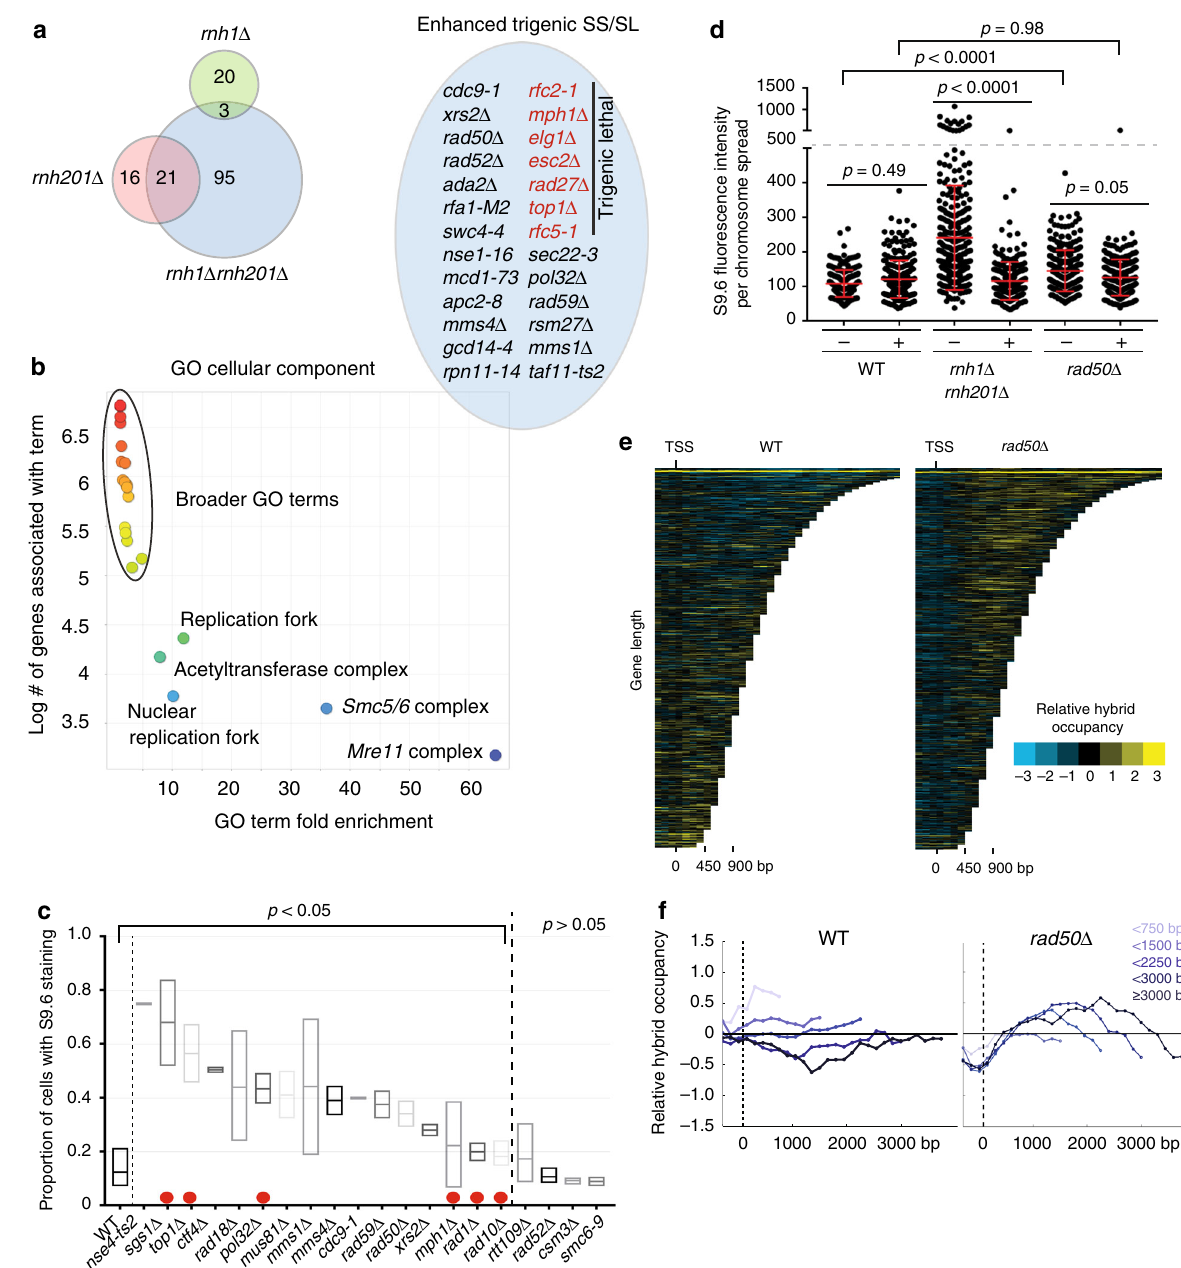
Fig. 1 RNaseH-de fi cient yeast depend on replisome function and fork protection for fi tness. a Negative genetic interaction results of double and triple mutant SGA screens with the indicated query genotype. A Venn diagram of candidate negative genetic interactions is shown (left) and validated hits that are sicker as triple mutants are in the blue circle. b Gene Ontology analysis of negative rnh ΔΔ -interacting partners. Plots show the output of ReviGO, which effectively trims redundant GO terms. c S9.6 staining of chromosome spreads in the indicated strains. Strains between the dotted lines had a signi fi cantly higher proportion of stained nuclei than WT (Fisher exact test. p < 0.05, Holm – Bonferroni corrected). Red dots indicate predicted positive controls (see main text). Box plots show the minimum and maximum values with the line at the mean value. d Validation of DNA:RNA hybrid increases in rad50 Δ cells. The minus and plus signs indicate that cells were grown without or with an RNH1 overexpression plasmid. e and f Mean genome-wide relative DNA:RNA hybrid occupancy in WT, and rad50 Δ as a function of gene length. Pro fi les were generated in duplicate. Quantile normalized and mean data are shown here. e Chromatra plots showing a heat map of DNA:RNA hybrid levels in WT, and rad50 Δ . f A total of 4868 genes were split into the indicated gene length categories (538 genes < 750 bp, 1861 genes < 1500 bp, 1263 genes < 2250 bp, 636 genes < 3000 bp, and 570 genes ≤ 3000 bp) with mean enrichment scores calculated and plotted for each category de fi cient yeast 31 . Therefore, we fi rst con fi rmed by quantitative that deletion of RAD50 led to increased DNA:RNA hybrid growth curve analysis that triple mutants of rnh ΔΔ and either formation by quantifying S9.6 staining in rad50 Δ yeast with or rad50 Δ or xrs2 Δ had a signi fi cant loss of fi tness (Supplementary without RNH1 overexpression (Fig. 1d). This analysis con fi rmed Fig. 1B). MRE11 and RNH1 are linked genes on yeast chrXIII so that loss of RAD50 increased S9.6 staining in an RNaseH1- triple mutants with mre11 Δ were not made. We also con fi rmed sensitive manner. NATURE COMMUNICATIONS| (2019) 10:4265